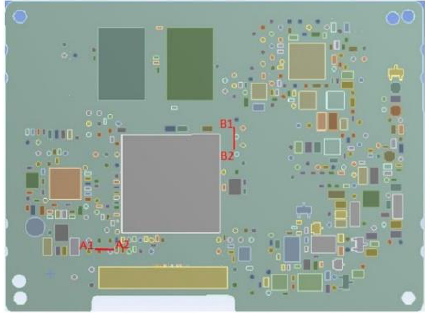
Figure 12. Definition of strain evaluation zones.